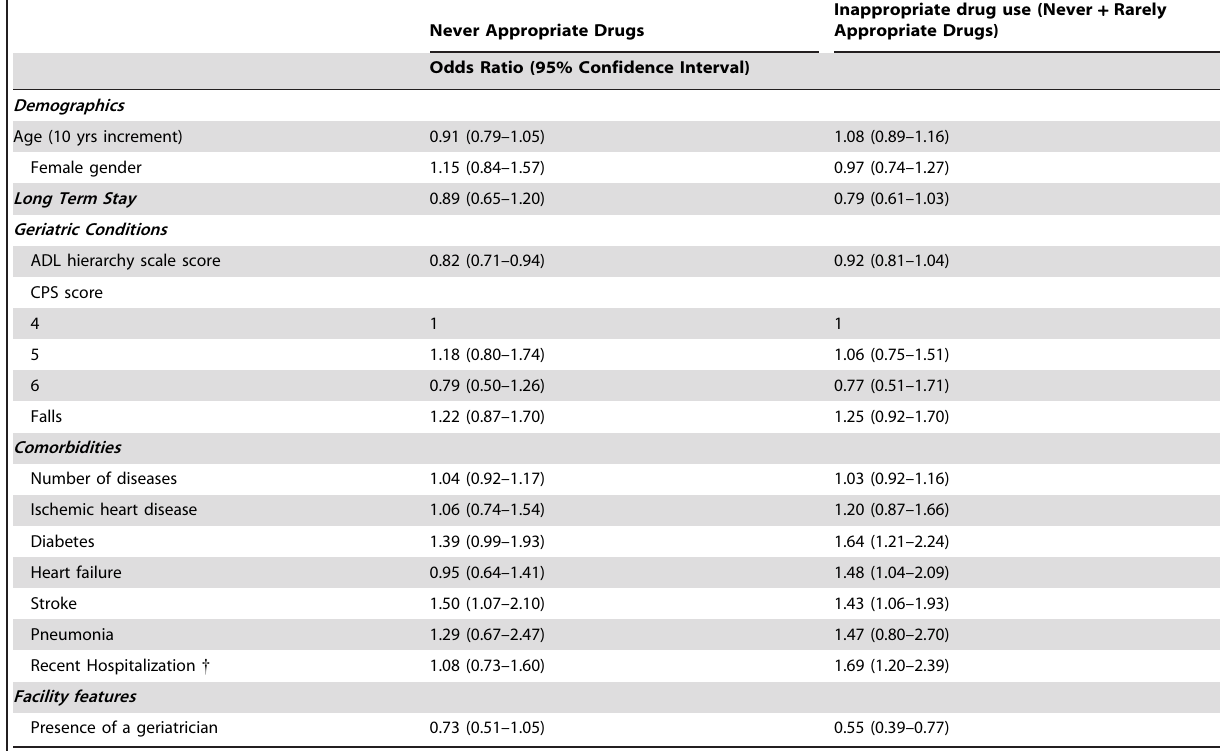
Table 3. Factors associated with inappropriate drug